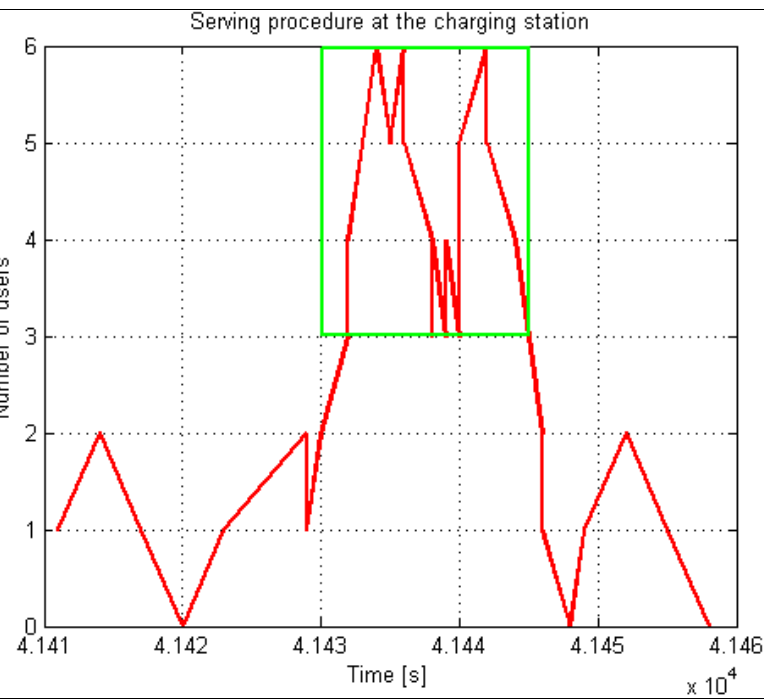
Figure 17. Activity and utilization of the service charging system in the entire observed period. P = 15, U = 17.